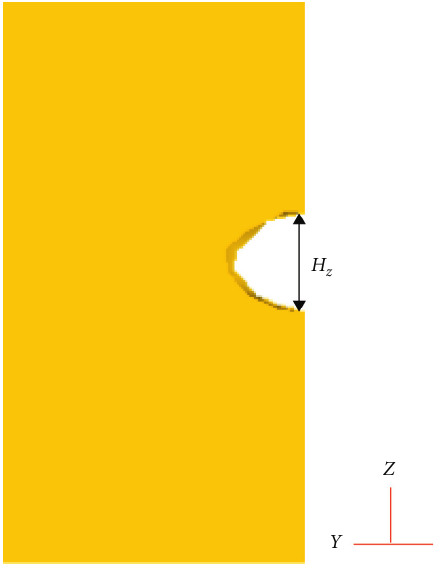
Figure 2: Void closure height H